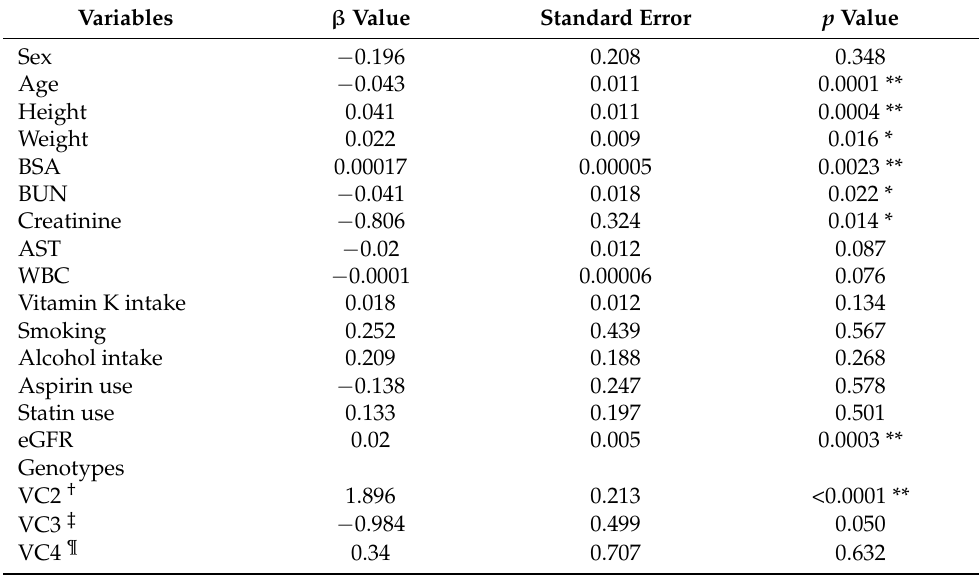
Table 3. Univariable associations between variables and the warfarin maintenance dose.